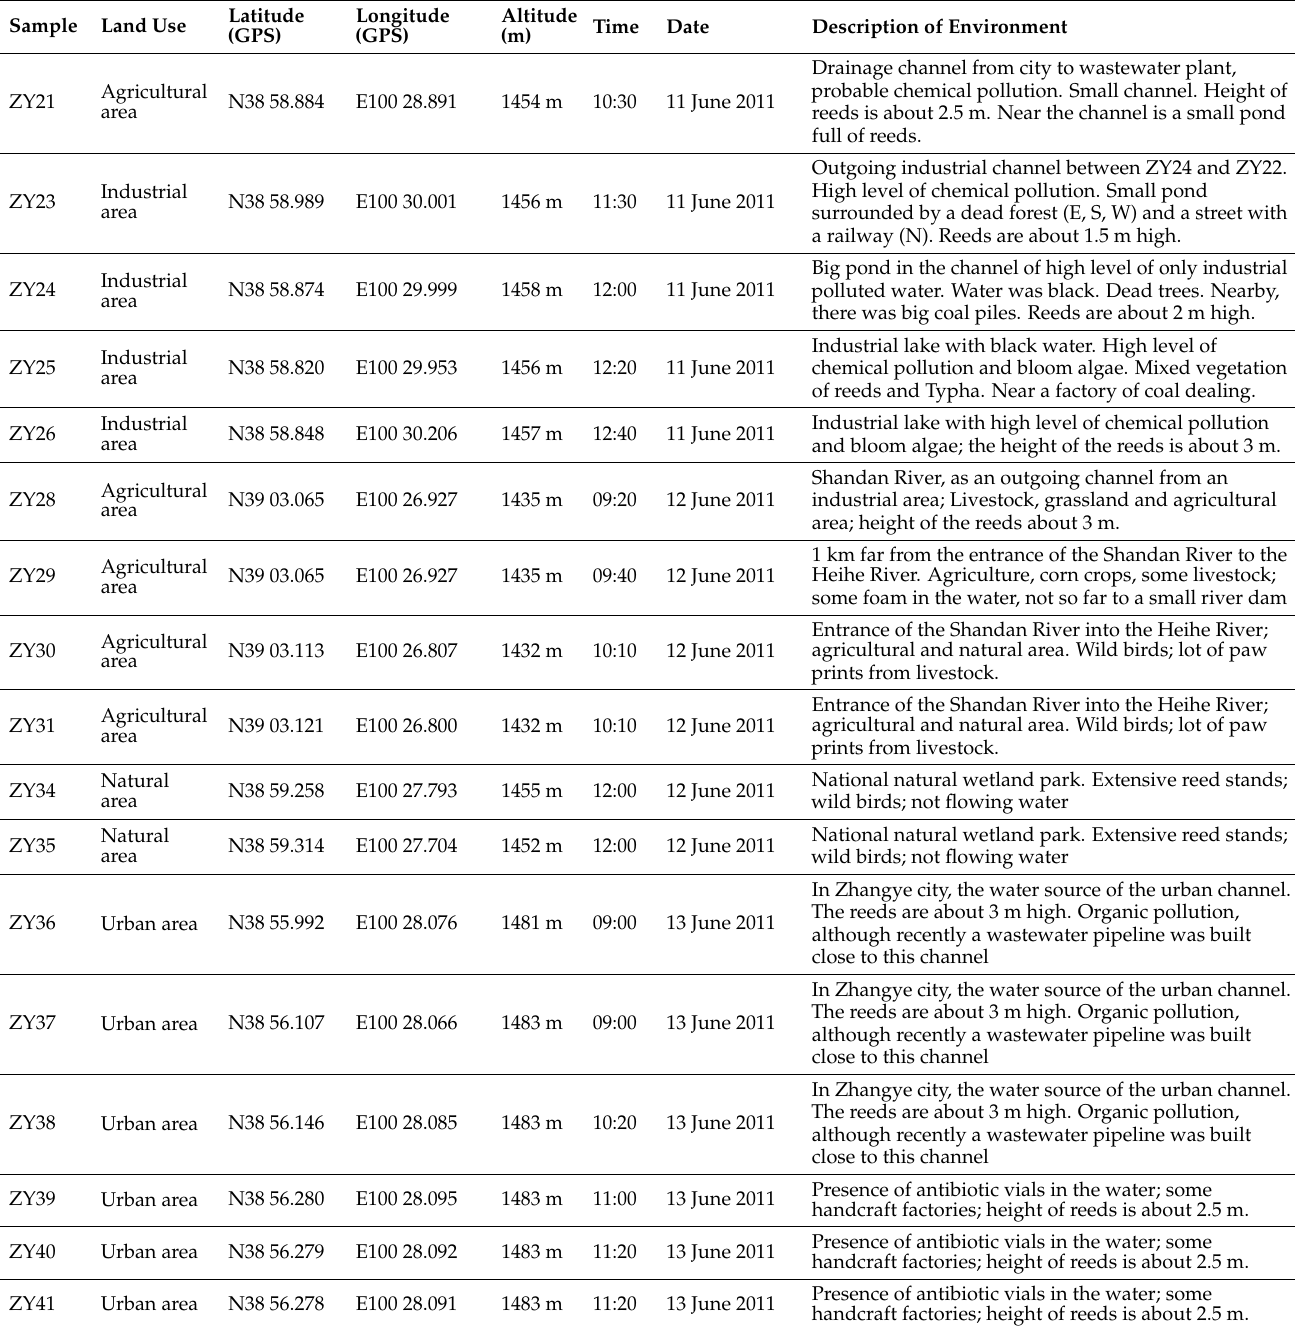
Table 1. The sampling sites, land use, GPS coordinates, times and date and the descriptions of the environments according to their